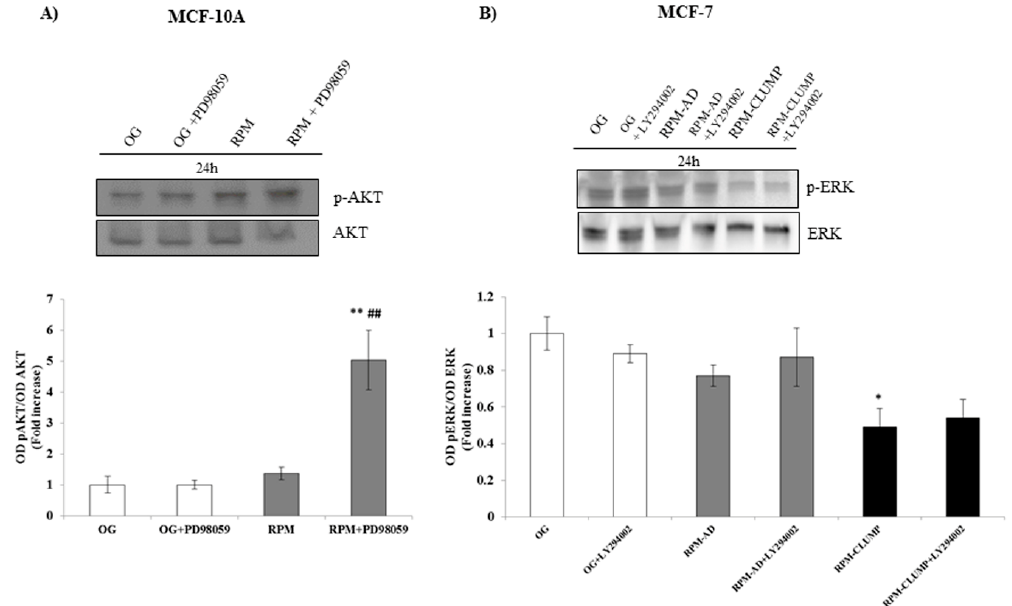
Figure 13. Immunoblot bar chart showing the expression of the p-AKT/AKT ratio and p-ERK/ERK ratio in MCF-10A ( A ) and MCF-7 ( B ) in on-ground control cells, RPM adherent cells, and RPM cell clumps at 24 h w/o the p-ERK inhibitor. PD89059, and w/o the p-AKT inhibitor, LY294002, respectively. Columns and bars represent densitometric quantification of the optical density (OD) of the p-AKT and p-ERK signal normalized with the OD values of AKT and ERK serving as the loading control. Each column represents the mean value ± SD of three independent experiments. * p < 0.05, ** p < 0.01 vs. OG; ## p < 0.01 vs. RPM by ANOVA followed by Bonferroni post-test.